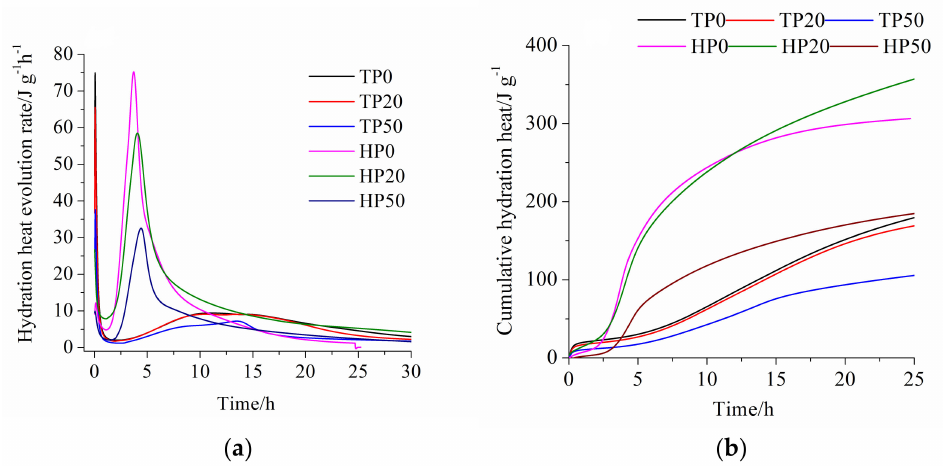
Figure 2. Hydration heat of blended cement containing ITP at 20 ◦ C and 60 ◦ C: ( a ) exothermic rate; ( b ) cumulative hydration